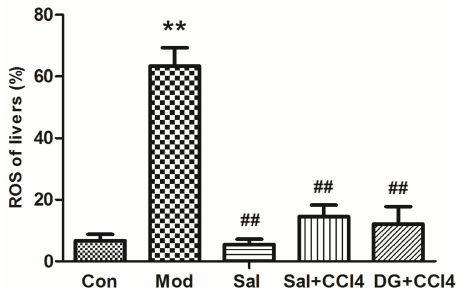
Figure 5. Salidroside inhibited liver reactive oxygen species (ROS) generations in the mice of di ff erent groups, that is, model mice induced by CCl 4 and mice treated with single salidroside, salidroside + CCl 4 , and diammonium glycyrrhizinate + CCl 4 (Con, Mod, Sal, Sal + CCl 4 , and DG + CCl 4 groups, respectively). CCl 4 caused excessively high ROS, whereas salidroside and DG e ff ectively normalized the ROS levels. p < 0.05 is statistically significant. ** p < 0.05 (groups compared with the Con group) and ## p < 0.05 (groups compared with the Mod group). (CCl 4 : carbon